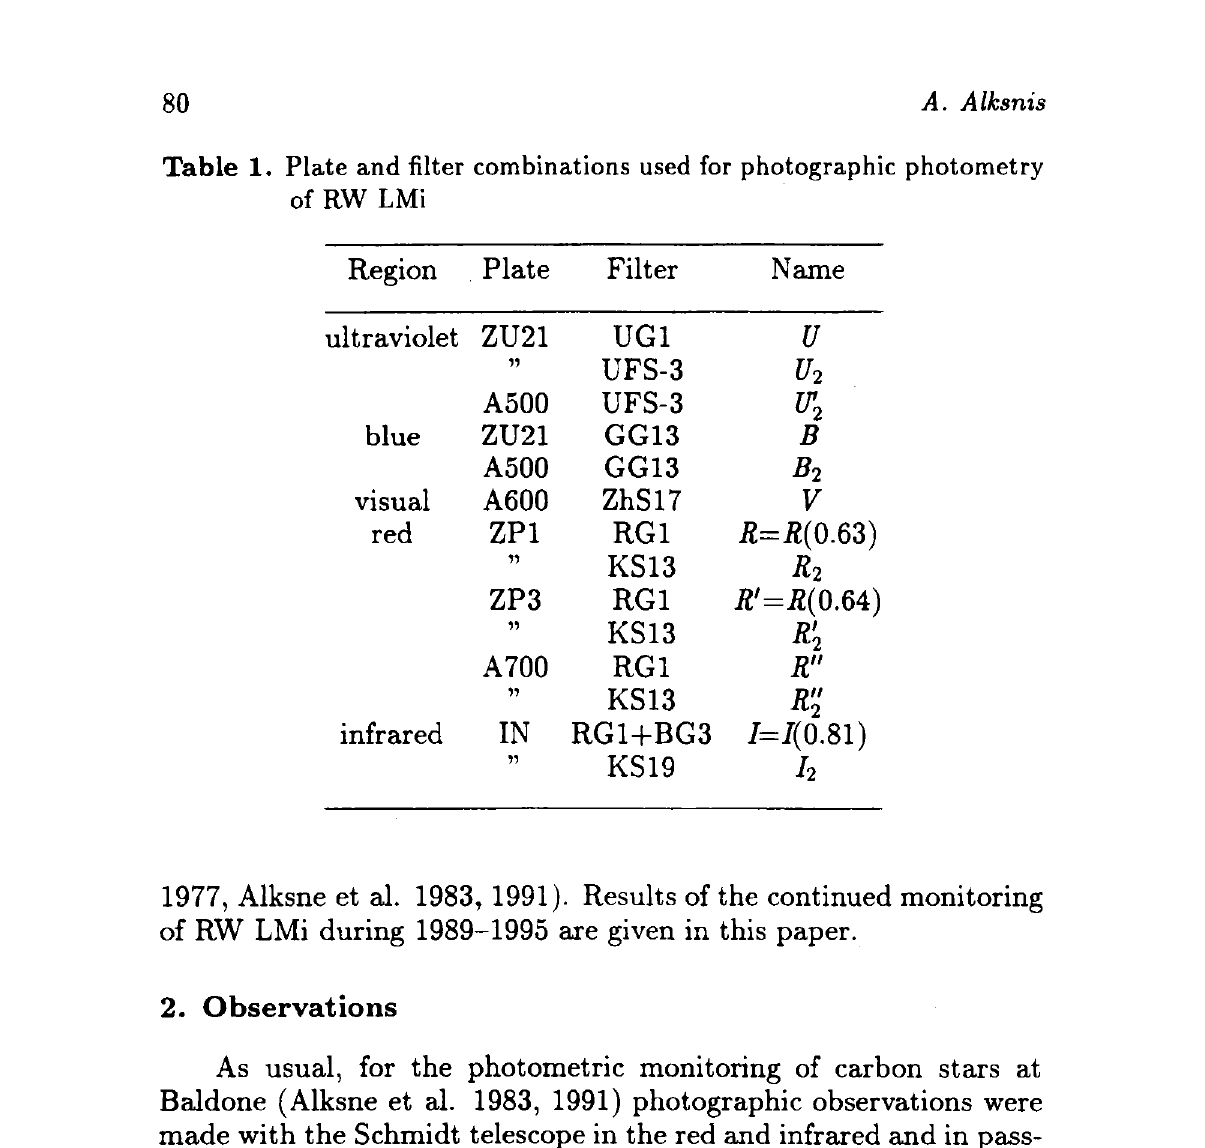
Table 1. Plate and filter combinations used for photographic photometry of RW LMi Region Plate Filter